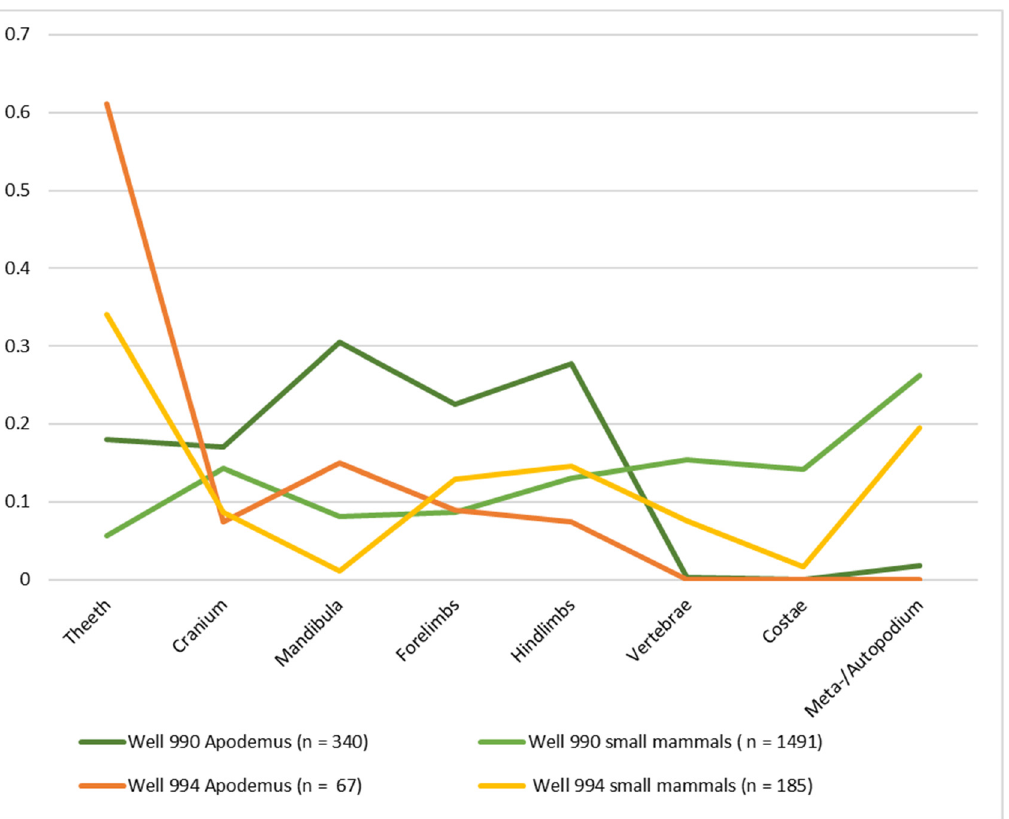
Figure 6. Proportions (%) of cranium, mandibula, isolated teeth and postcranial body parts of Apodemus cf. sylvaticus and of combined small mammal categories Muridae/Arvicolidae and small mammals indet. from wells 990 and 994.